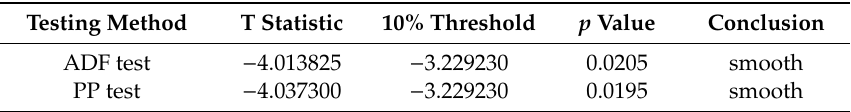
Table 6. Residual stability test.